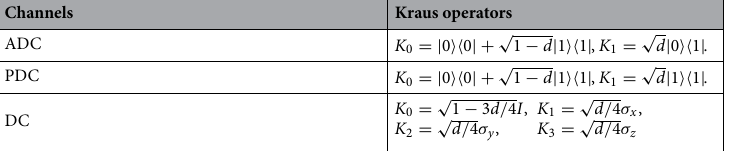
Table 1. Kraus operators for the corresponding ADC, PDC and DC, where d decoherence strength. { σ x , σ y , σ z } represent Pauli operators.